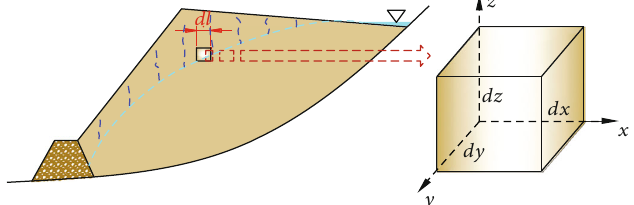
Figure 12: Tailing element